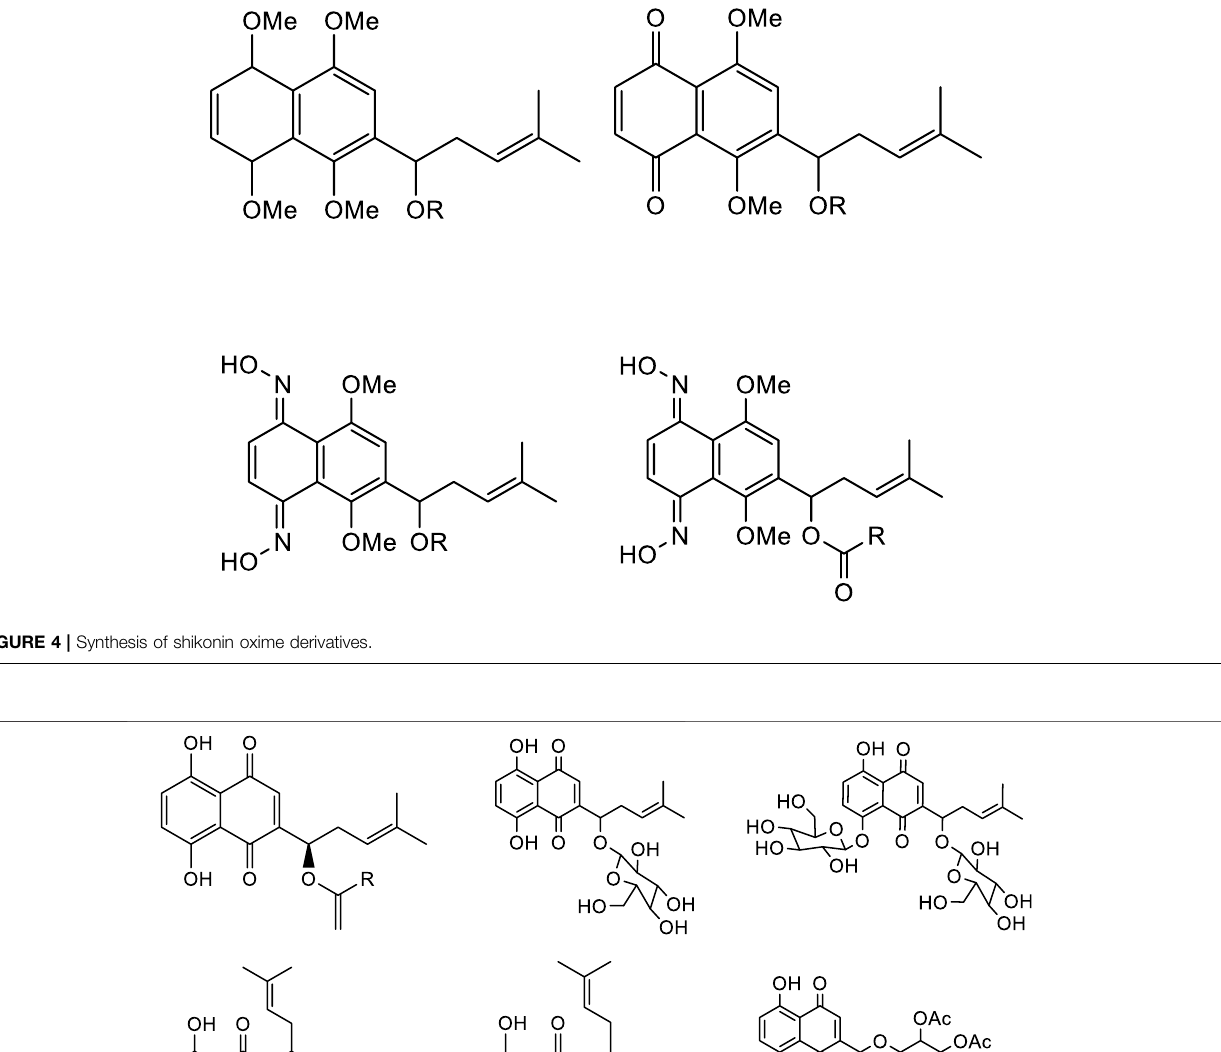
FIGURE 5 | Synthesis of acetyl- β